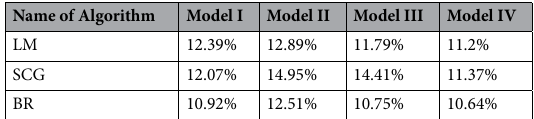
Table 16. MAPE of each model.